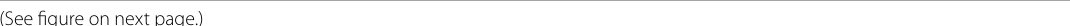
difference (Fig. 1J–L and Additional file 1: Table S2), indicating the antagonistic roles for GS3.1 and GS3.2 in grain size regulation. It is well studied that GS3 asso- ciates with RGB1 to negatively regulate grain size (Sun with RGB1 is raised. First, yeast two-hybrid assay was performed to detect the interaction between GS3.2